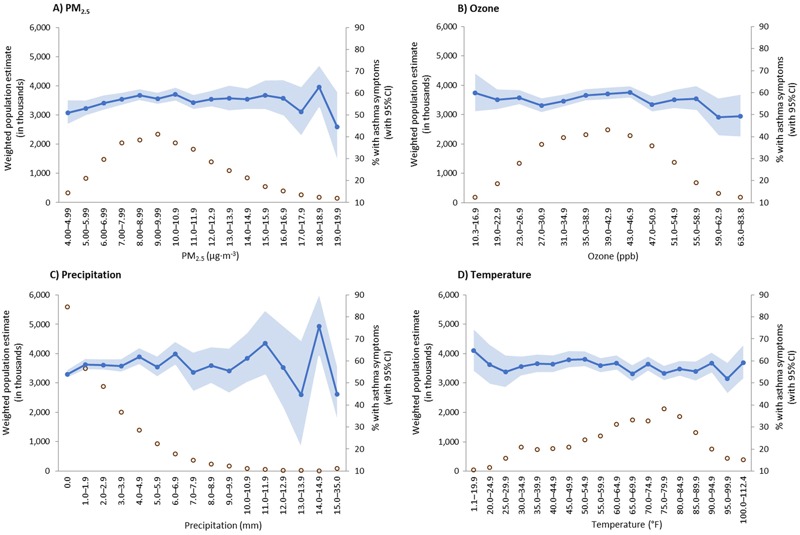
Weighted estimates of the population with active asthma (open circles) and estimated percentages of adults with asthma symptoms in the past 14 days (filled circles) across categories of particulate matter ≤ 2.5 μm in diameter (PM2.5) (A), ozone (B), precipitation (C), and temperature (D). Formula for conversion from degrees Fahrenheit (TF) to degrees Celsius (TC): TC = (TF – 32) × (5/9).